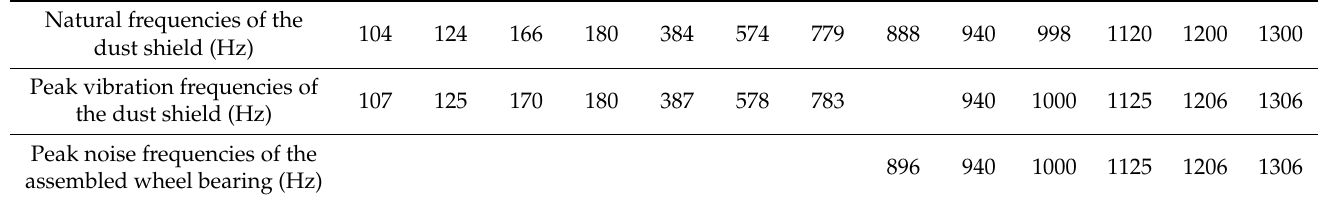
Figure 7. Frequency response functions obtained from the modal testing of dust shield. Table 2. Comparison of the natural frequencies of the dust shield, peak vibration frequencies of the dust shield, and peak noise frequencies of the assembled wheel bearing.